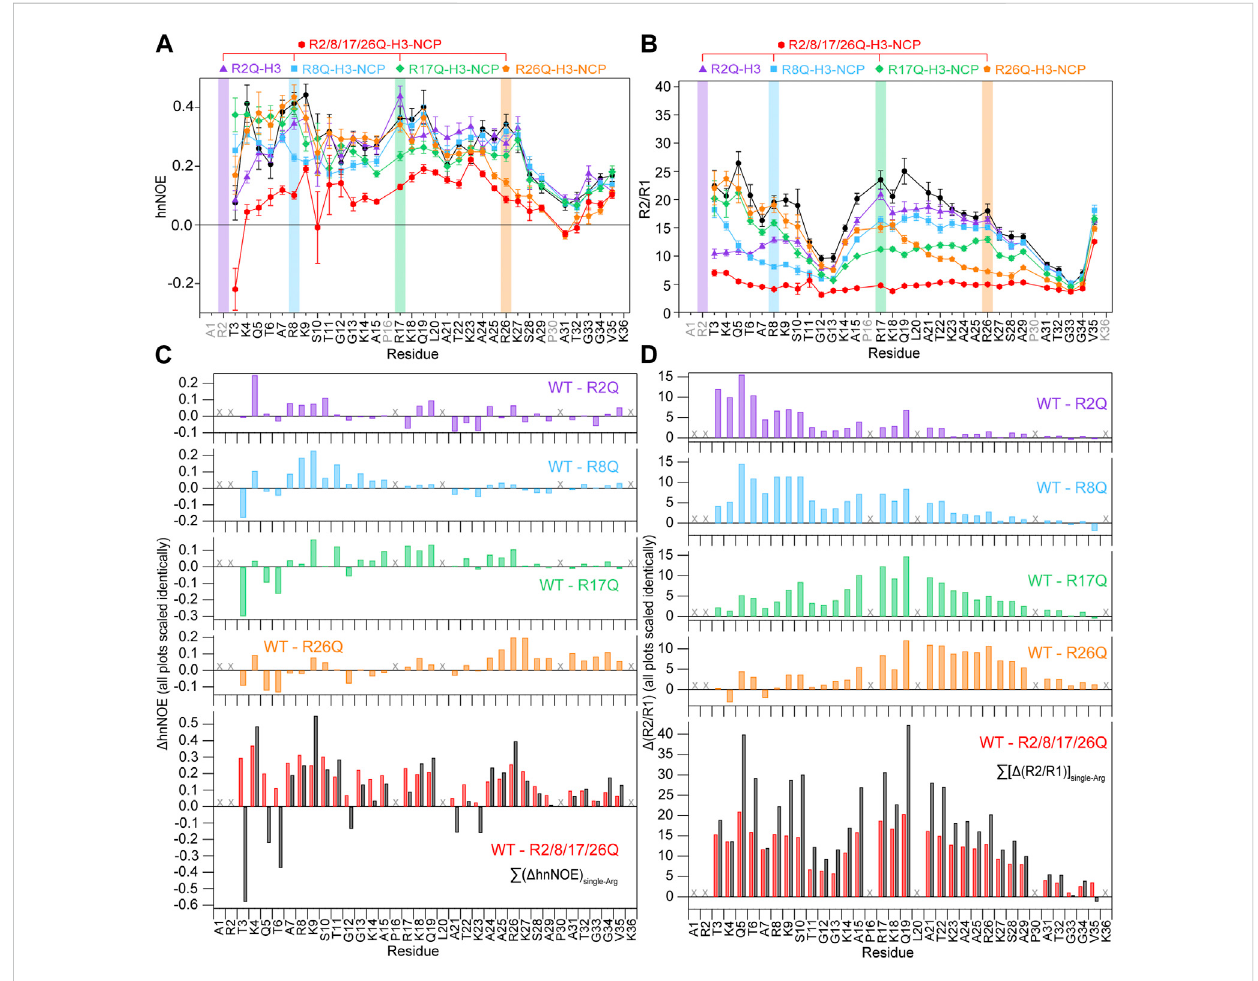
FIGURE 5 Neutralizing H3 tail arginines leads to a more global increase in H3 tail dynamics at 150 mM KCl. Plots are shown for (A) hnNOE values and (B) R2/ R1as afunctionofresidueforWT-(black circles),R2Q-(purpletriangles),R8Q- (blue squares), R17Q-(greendiamonds),R26Q-(orange pentagons),and R2/8/17/26Q-H3-NCP (red hexagons). Error bars represent standard error propagation of the spectral noise for hnNOE values and were determined via the covariance matrix in fi tting R1 and R2 decay curves, which was subsequently propagated for R2/R1. Note that some error bars are smaller than the symbols. Difference plots for (C) hnNOE and (D) R2/R1 show the difference between the per-residue hnNOE or R2/R1 for the H3 tail within 15 N-WT- H3-NCP and within each single-arginine mutant (top four plots). The bottom plots show the difference between WT- and R2/8/17/26Q-H3-NCP (red) and the sum of the four difference plots for each single-arginine mutant (i.e., Δ hnNOE WT-R2Q + Δ hnNOE WT-R8Q + Δ hnNOE WT-R17Q + Δ hnNOE WT-R26Q on the lower left and Δ (R2/R1) WT-R2Q + Δ (R2/R1) WT-R8Q + Δ (R2/R1) WT-R17Q + Δ (R2/R1) WT-R26Q on the lower right) (black). “ X ” symbols mark residues omitted from analysis. Data were collected at 150 mM KCl, 800 MHz, and 304